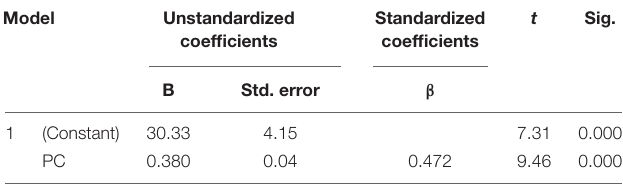
TABLE 5 | Coefficients for Chinese EFL PC and JC.